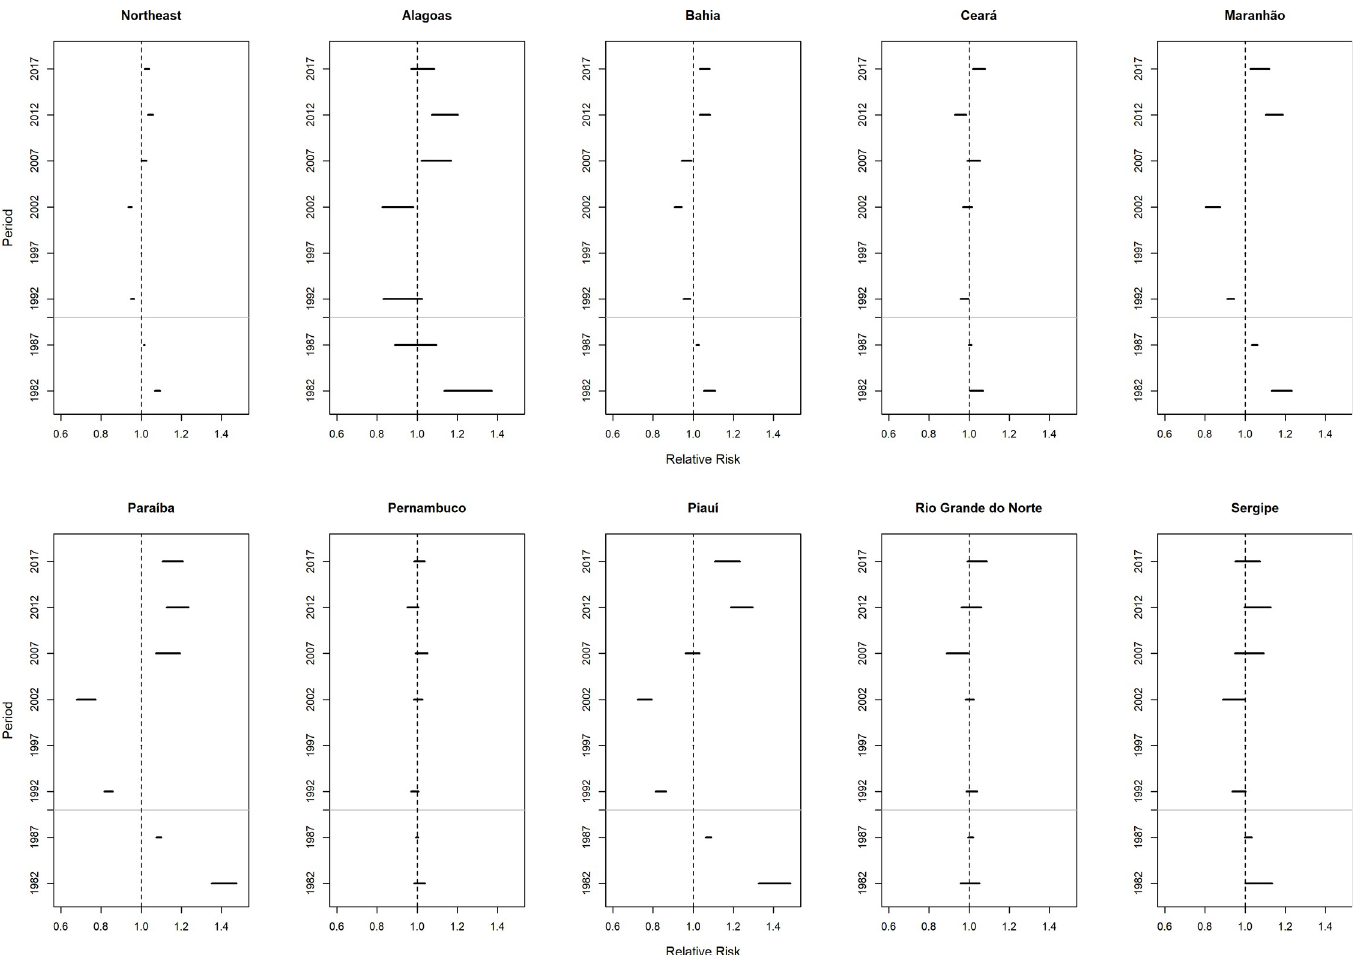
Fig 8. Results of the age-period-cohort model adjusted for breast cancer mortality according to the period effect and states of the Northeast, Brazil, 1980–2019.